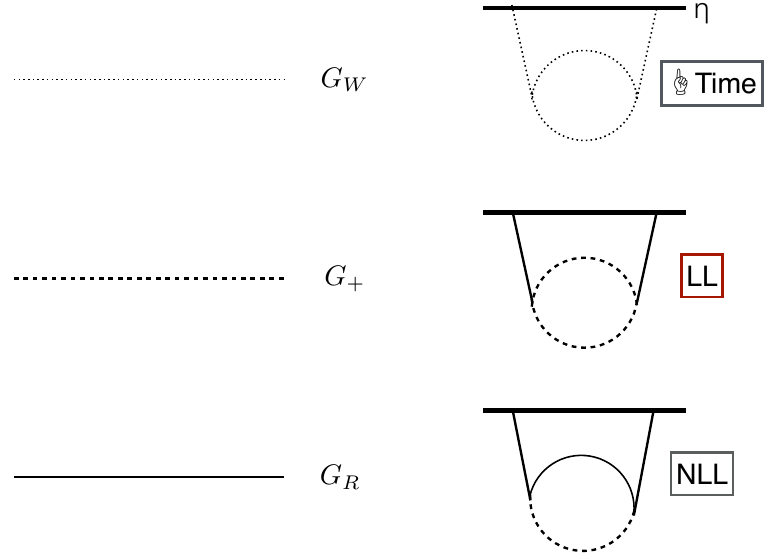
Figure 2 . Left: our graphical notation for the various propagators of interest. Right: in a (cid:30) 3 theory, we show second-order contributions to (cid:30) ( (cid:17); ~x ) (cid:30) ( (cid:17); ~y ) , where the solid bar at the top of h i each diagram indicates the correlation time, (cid:17) . The top graph (cid:12)xes a particular topology for this contribution, all of which will come from various contributions of Wightman functions and time orderings. We can decompose the various contributing two-point functions purely in terms of G + and G R . The middle graph shows a nonvanishing contribution in this basis that contributes at leading-log level by having the minimum number of allowed G R factors and places them consistently with rules 1) and 2). Lastly, the bottom graph is subleading-log as it contains more than the minimum number of G R